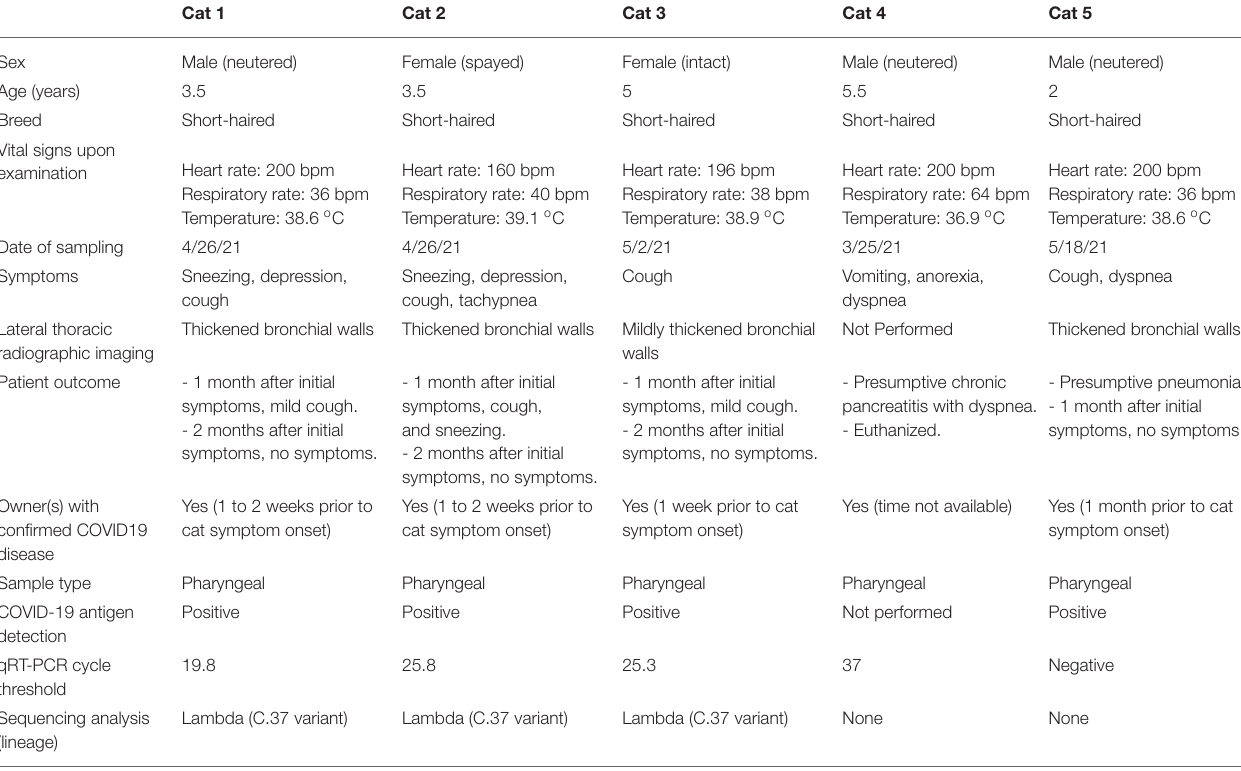
TABLE 1 | Characteristics of four domestic cats with suspected SARS-CoV-2